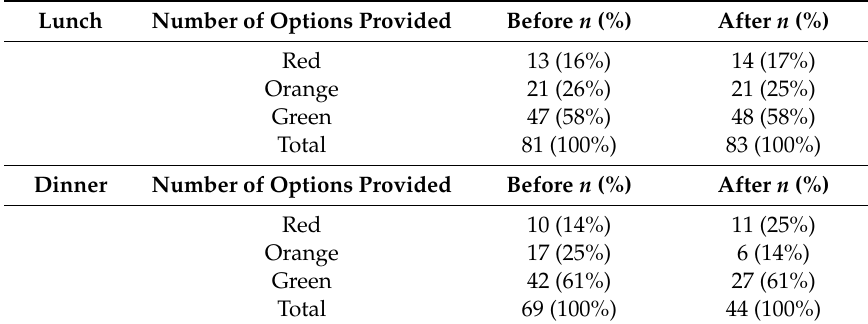
Table 3. Number of options 1 provided in the bu ff et, by health category, before and after, sourced directly from the bu ff et